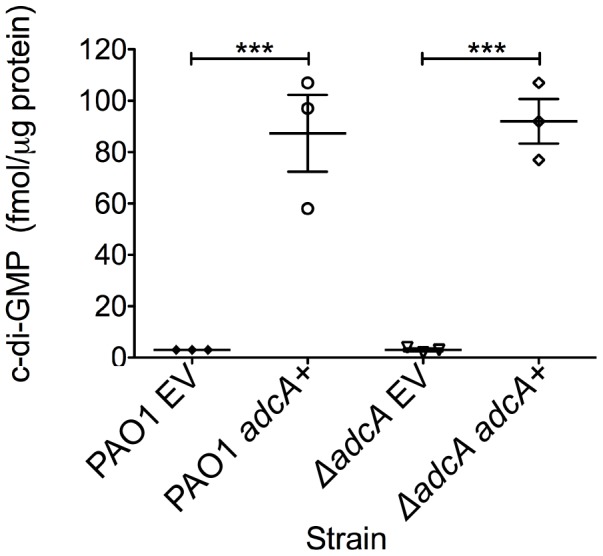

PA4843 (adcA) encodes diguanylate cyclase.Expression of adcA increases intracellular c-di-GMP. adcA was cloned into an arabinose-inducible vector and strains were grown on LANS plates with 0.5% arabinose overnight. Direct LC-MS/MS measurement of c-di-GMP revealed that both PAO1 and ΔadcA containing the empty vector (EV) accumulated minimal amounts of c-di-GMP, while induction of adcA (adcA+) was correlated with high accumulation of intracellular c-di-GMP. Each graph point represents the average of three biological replicate performed in triplicates. Significance determined using Student's t-test (*** p≤0.001)